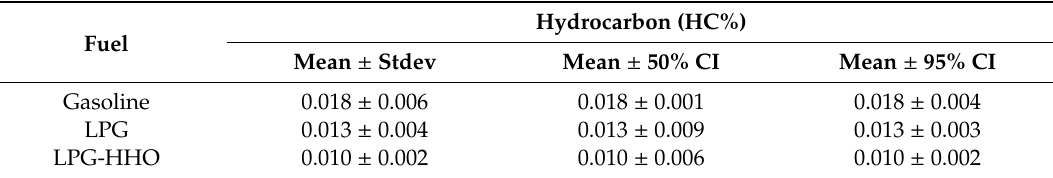
Table 5. 50% and 95% confidence intervals for mean HC